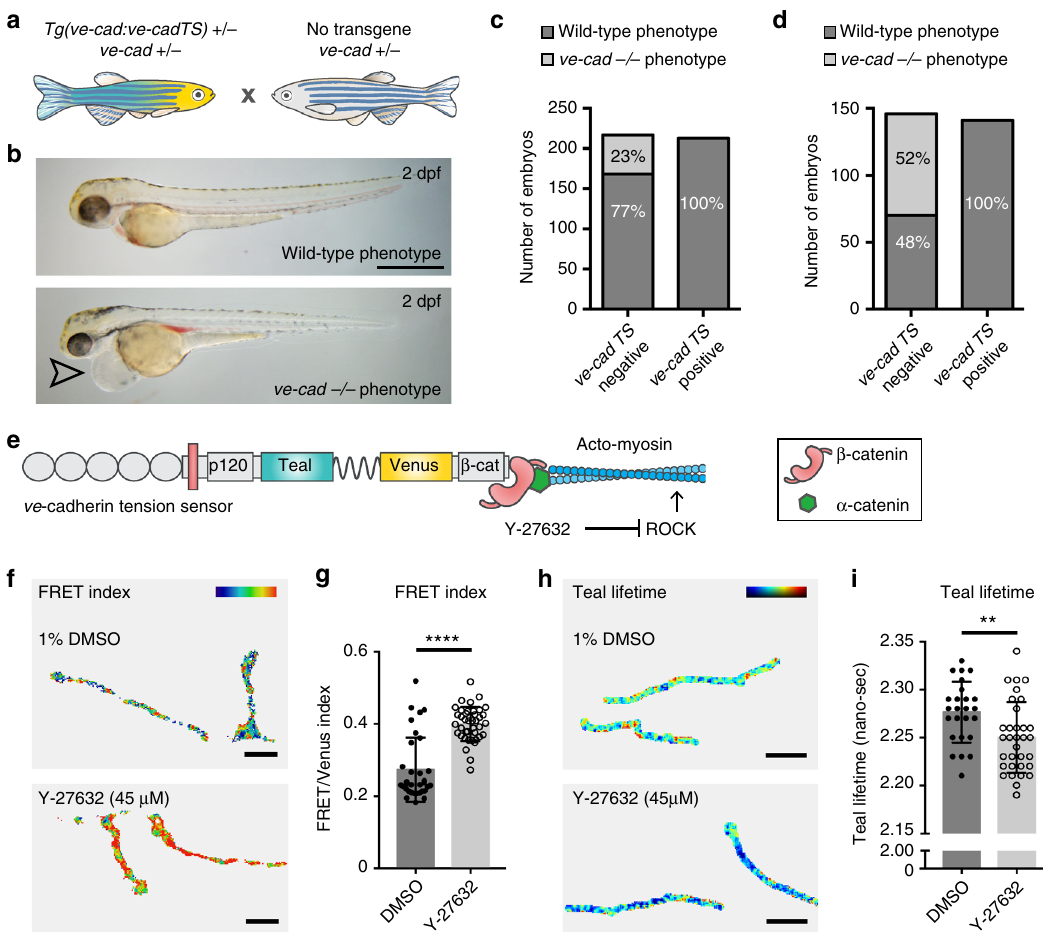
Fig. 2 VE-cadherin-TS is functional and under acto-myosin controlled tension. a Schematic representation of genetic cross to test functionality of VE- cadherin-TS. b Wild-type (top) and ve-cadherin mutant (bottom) phenotype at 2 dpf (arrowhead indicates cardiac oedema in mutant). Scale bar = 1 mm. c Phenotypic scoring all embryos ( n = 430) collected from cross in a, showing 23% phenotypic mutants ( n = 49/217) in TS-negative population ( n = 217) and 0% ( n = 0/213) in TS-positive siblings ( n = 213). d Phenotypic scoring of n = 286 embryos from a cross between a Tg ( ve-cad:ve-cadTS ) + / − , cdh5 ubs8 − / − mutant and a non-transgenic cdh5 ubs8 +/ − animal. In the TS negative population 52% ( n = 76/146) displayed the mutant phenotype whilst there were no phenotypic mutants in the TS positive clutch ( n = 141). e Schematic representation of Y-27632 (ROCK inhibitor) acto-myosin inhibition. f Heatmap image of ratio-metric FRET values in junctions of 1%DMSO and Y-27632 (45 μ M/1%DMSO) treated embryos. Colors range from blue ( = low FRET index/ high tension) to red ( = high FRET index/low tension). Scale bar = 5 μ m. g Quanti fi cation of ratio-metric FRET values in junctions of 1 % DMSO ( n = 4) versus Y-27632 (45 μ M/1%DMSO) ( n = 5) treated embryos. Each data point represents a junctional region of interest (ROI), n = 33 junctions selected from DMSO control embryos and n = 40 selected in Y-27632 treated embryos. Treatment for 5 h prior to imaging. Error bars represent mean ± s.d.; **** p < 0.0001 from unpaired two-sided Mann – Whitney test. h Heatmap image of Teal lifetime values in junctions of 1%DMSO (top) and Y-27632 (bottom, 45 μ M/1%DMSO)- treated embryos. Colors range from blue ( = low lifetime/low tension) to red ( = high lifetime/high tension). Scale bar = 5 μ m. i Quanti fi cation of Teal lifetime values (nano-sec) in junctions of 1 % DMSO ( n = 4) versus Y-27632 (45 μ M/1%DMSO) ( n = 4) treated embryos. Each data point represents a single junctional ROI, n = 25 junctions segmented from DMSO control embryos and n = 33 from Y-27632 treated embryos. Treatment for 5 h prior to imaging. Error bars represent mean ± s.d.; ** p = 0.0060 from unpaired two-sided t